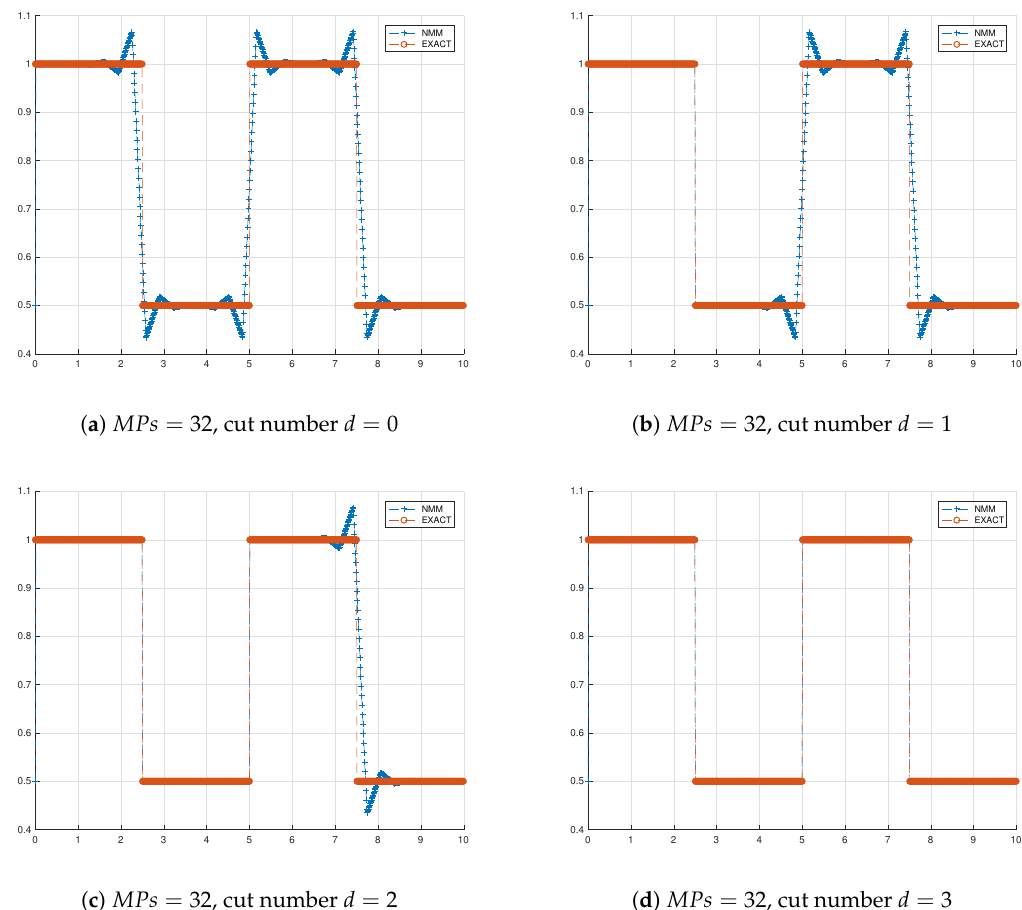
Figure 6. As the number of cuts increases, the function approximation becomes more and more accurate. When the number of discontinuities is equal to the number of cuts, the function in the figure can be accurately approximated. The discontinuities of the function are at 2.5,5 and 7.5.